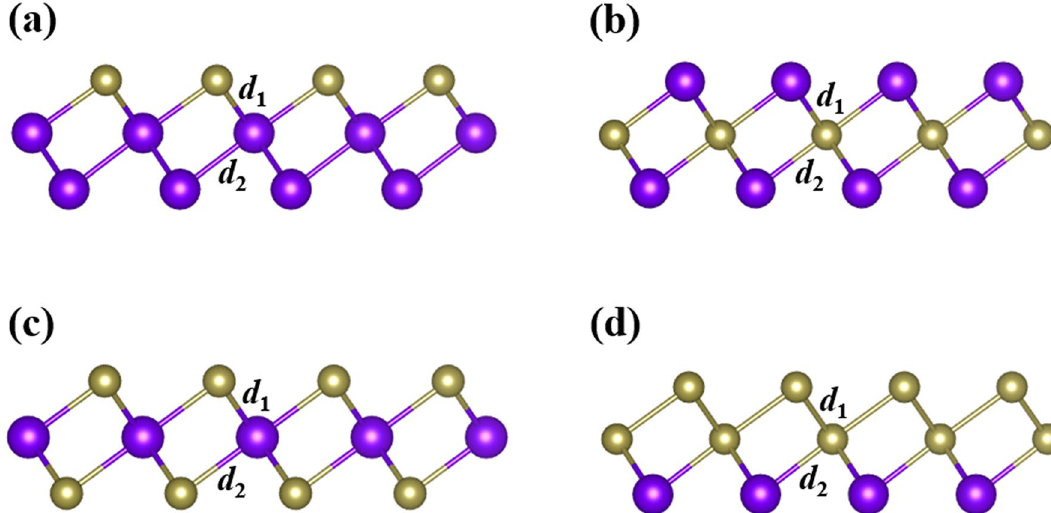
Figure 4. Geometrical structures for the trigonal poloniumene MLs with four doping patterns of ( a ) XPoPo, ( b ) PoXPo, ( c ) XPoX, and ( d ) XXPo, in which X = S, Se, Te atoms. The purple spheres indicate the Po atoms while the brown spheres denote the X atoms.